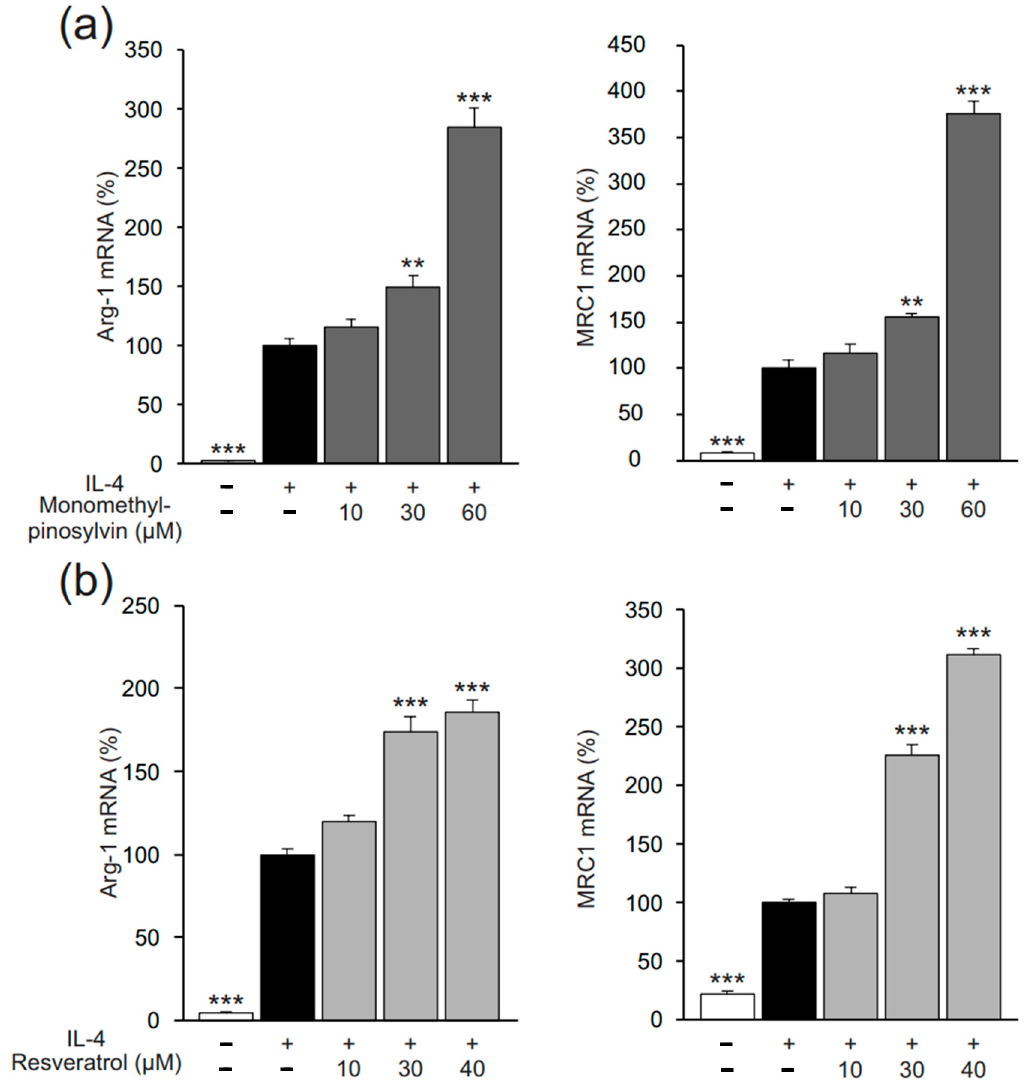
Figure 3. Monomethyl pinosylvin ( a ) and resveratrol ( b ), two natural stilbenoids selected as comparison compounds for pinosylvin, also enhanced IL-4-stimulated expression of markers of alternative (M2-type) macrophage activation in J774 murine macrophages. J774 cells were cultured with IL-4 (10 ng/mL) alone, or together with monomethyl pinosylvin ( a ) or resveratrol ( b ) for 24 h. Expressions of arginase-1 (Arg-1) and mannose receptor C type 1 (MRC1) mRNA were measured by quantitative reverse transcriptase polymerase chain reaction (qRT-PCR) and normalized against GAPDH mRNA. The results are expressed as mean + SEM, n = 6 ( a ) or n = 4 ( b ). Statistical significance of the results was calculated by one-way ANOVA followed by Bonferroni multiple comparisons test. ** = p < 0.01 and *** = p < 0.001 as compared to cells cultured with IL-4 only, marked as a black bar.